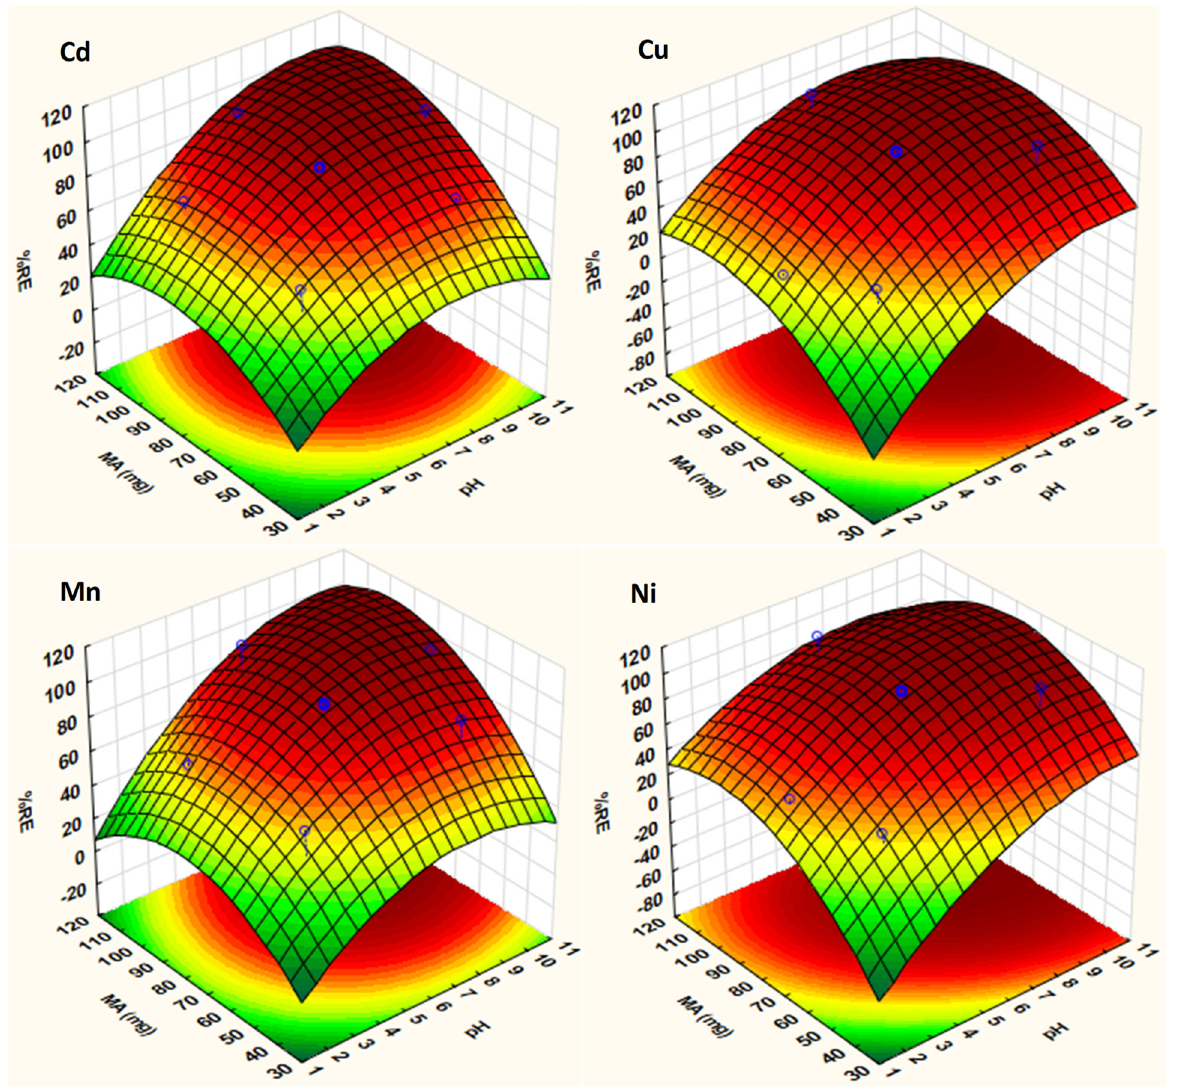
Figure 5. Response surface plots for the CCD obtained for each element.